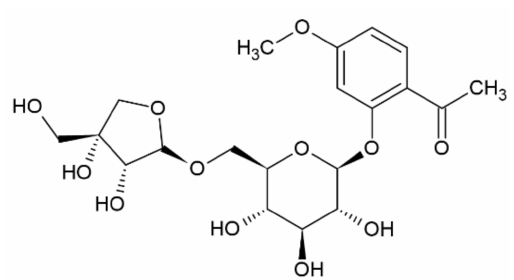
Figure 3. Chemical structure of compound 5